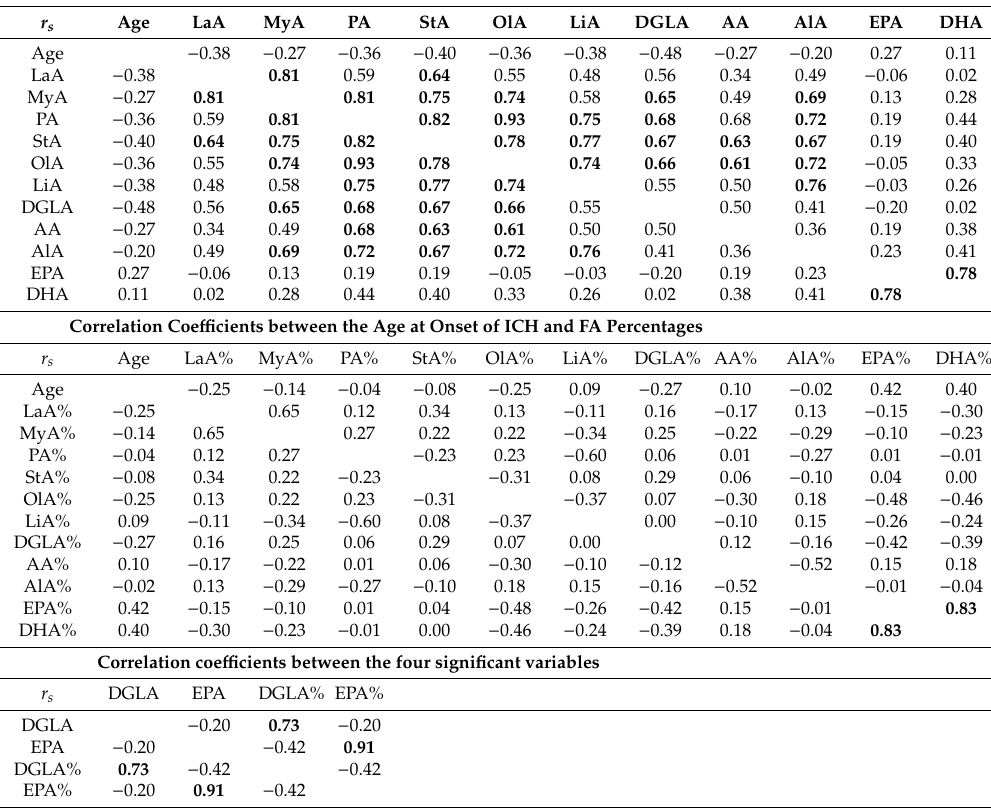
Table 3. Spearman correlation coe ffi cients. Correlation coe ffi cients between the age of ICH onset and FA